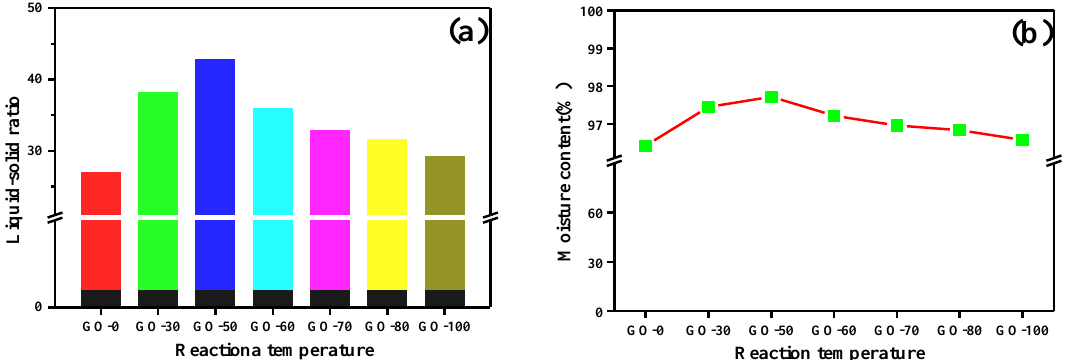
Figure 3. Liquid-solid ratio and moisture content of graphite oxide samples prepared at different reaction temperatures: ( a ) Liquid-solid ratio, ( b ) Moisture content.